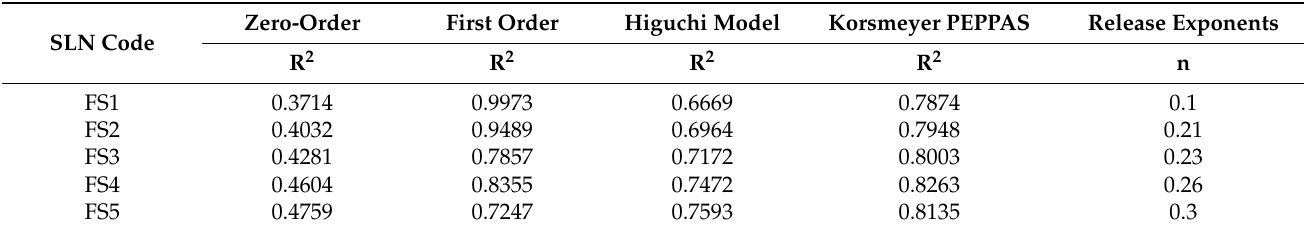
Figure 5. In vitro drug release profiles of FX-loaded SLNs. Table 2. Release kinetics mechanism of FX-loaded SLNs.